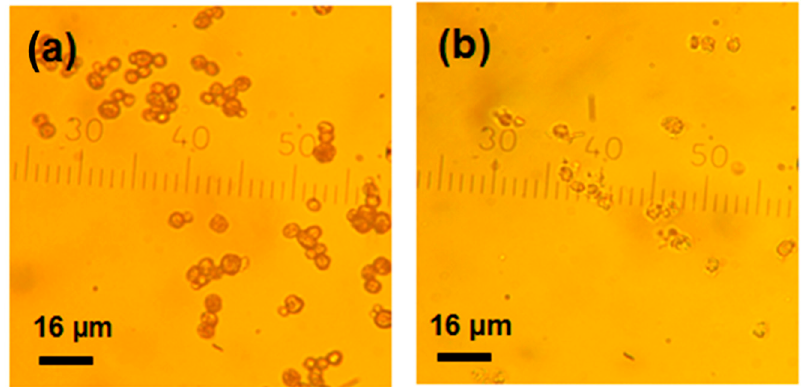
Figure 9. Optical microscopy images of polymer-coated crystals CaCO 3 (mucin-protamine) 3 ( a ) and multilayer capsules (mucin-ptotamine) 3 formed after addition of EDTA to the coated crystals ( b ). The CaCO 3 crystals contain mucin loaded by co-synthesis.